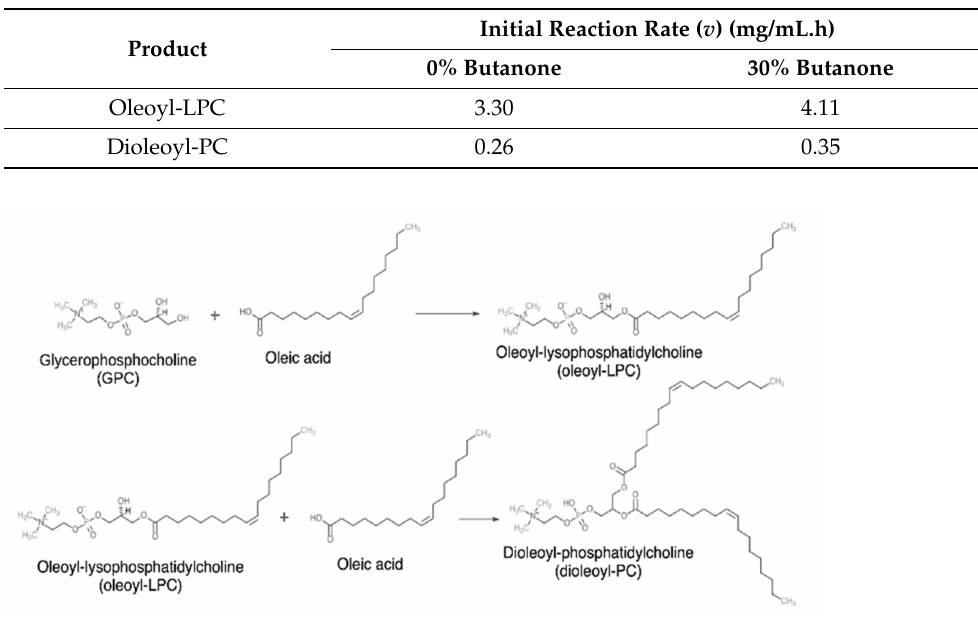
Figure 2. Scheme for esterification reaction of Glycerophosphocholine (GPC) with oleic acid.